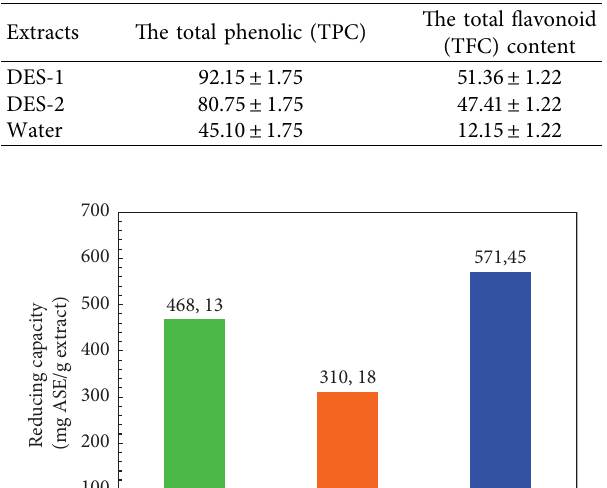
Table 5: Total phenolic and favonoid contents in grape pomace extracts.